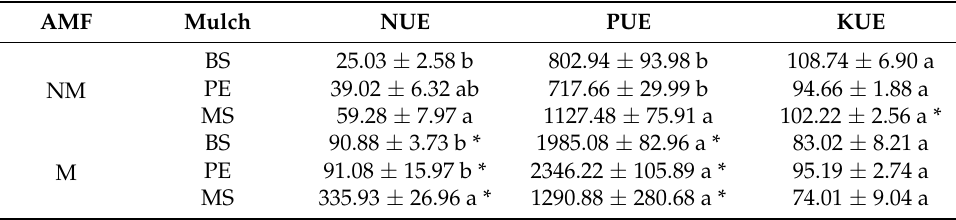
Table 3. Nutrient use efficiency of escarole plants (cv. Bekele) cultivated under non-mycorrhizal (NM) and mycorrhizal (M) conditions and covered or not with mulching treatments. AMF Mulch NUE PUE KUE BS 25.03 ± 2.58 NM